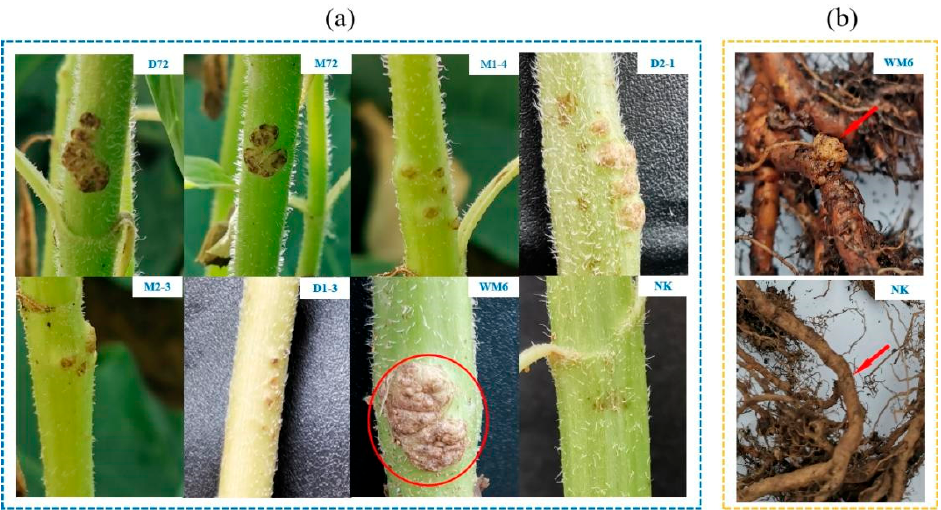
Figure 2. Pathogenicity test. ( a ) Symptoms of the onset of the disease one month after inoculation in sunflower plant stems; ( b ) symptoms of the onset of kiwifruit plant two months after inoculation. The strain number and control are marked.